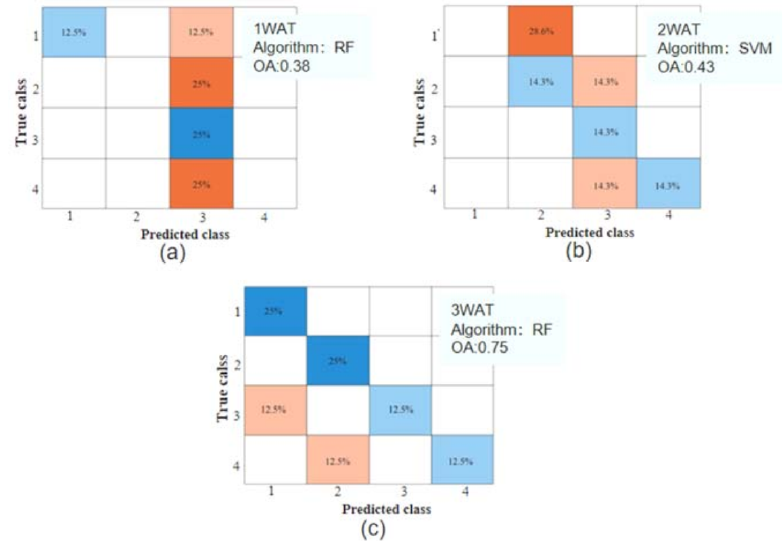
Figure 9. The confusion matrix corresponding to the machine learning algorithm with the highest accuracy in the assessment of recoverable plants and the glyphosate spray rates at 1 WAT ( a ), 2 WAT ( b ), and 3 WAT ( c